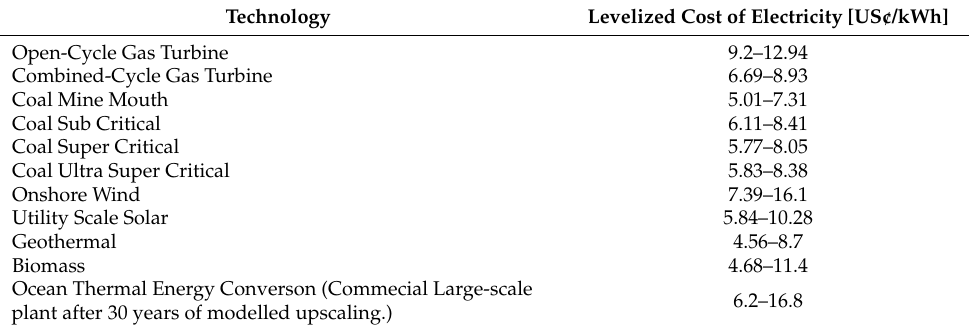
Table 2. The levelized cost of electricity of renewables and fossil-fuelled generators in Indonesia. Values for OTEC based on [20], values for all other technologies based on